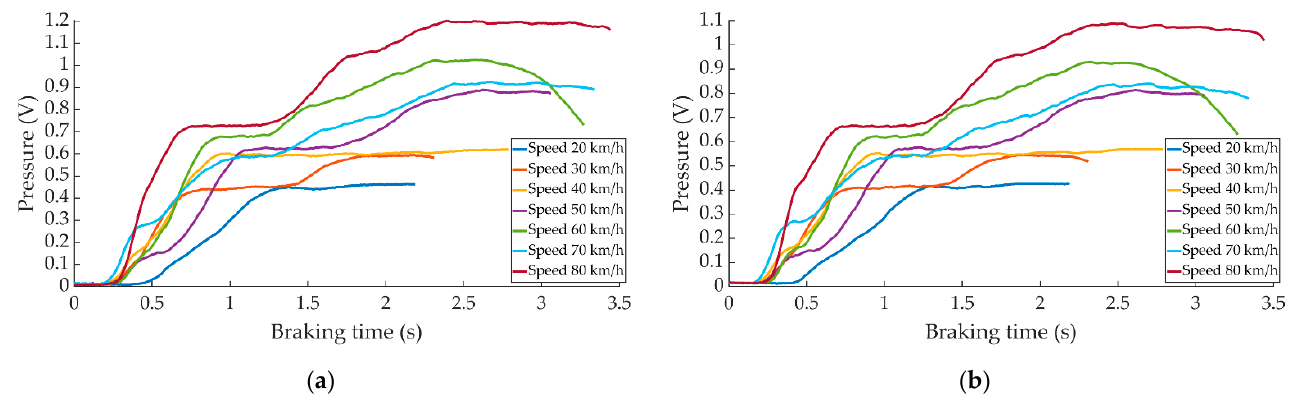
Figure 7. Curves of the data obtained during progressive braking for the different speeds by ( a ) the right pressure sensor and ( b ) left pressure sensor.